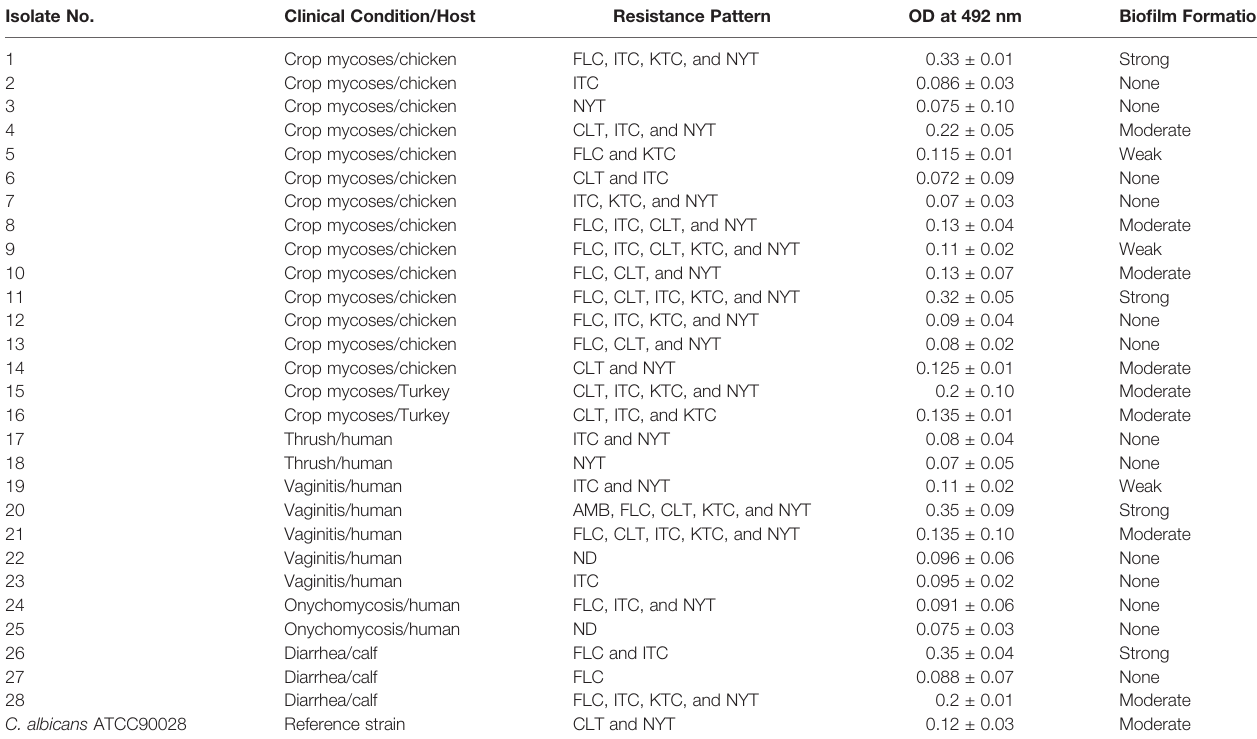
TABLE 1 | Bio fi lm formation ability and resistance patterns of C. albicans isolates. Isolate